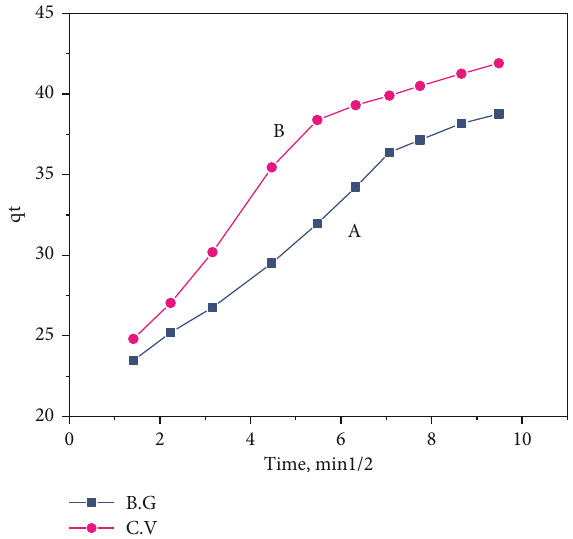
Figure 11: Impact of concentration of KNO percentage of B.G. (a) and C.V. (b) dyes from the aqueous phase onto the binary P3NT/30%AgTiO